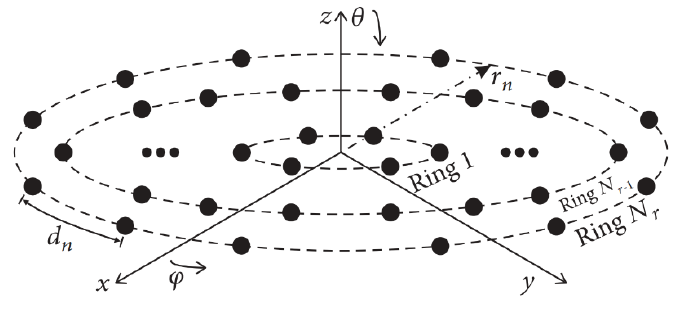
Figure 1. Non-uniform concentric ring array.